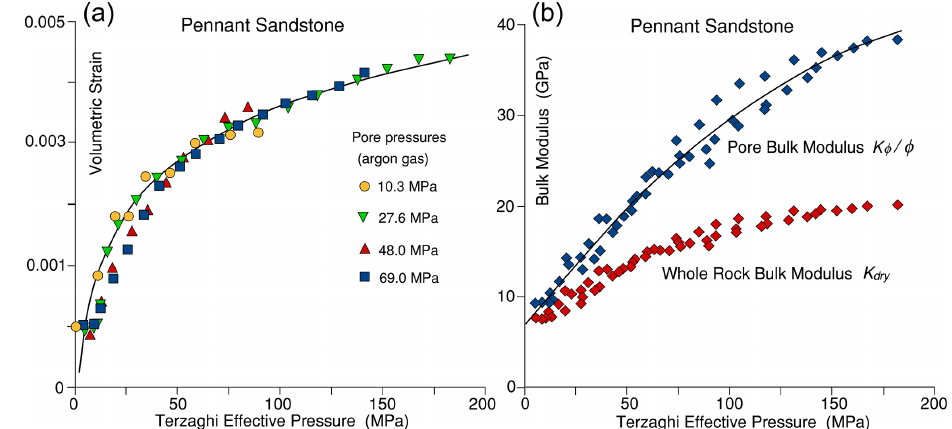
Figure 6. (a) Volumetric strain (with respect to whole sample volume) for Pennant sandstone at four different constant gas pore pressures. There is no significant effect of magnitude of pore pressure. About 20% of the total pore volume is elastically reduced over a range of 200MPa effective pressure. (b) Pore bulk modulus K φ /φ from gas expulsion data in (a) for Pennant sandstone and whole-rock bulk modulus calculated from K φ /φ and K o (41.5GPa). Pore spaces become rapidly less compliant as effective pressure increases.